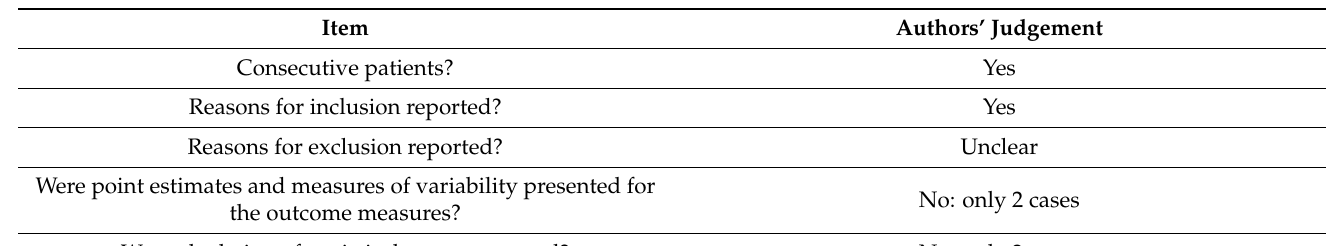
Table A2. Quality assessment.